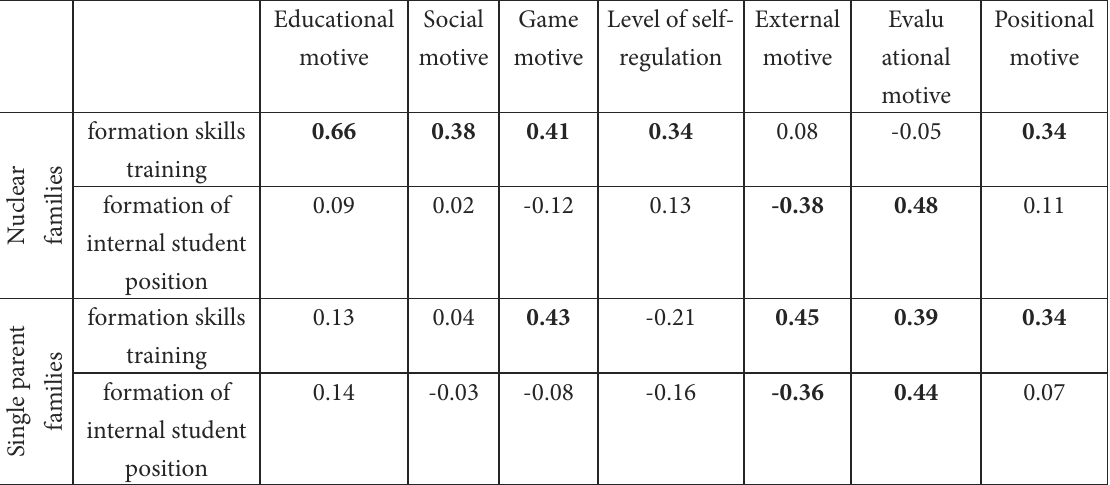
Tab 1. The correlation coef (cid:222) cients for personal indices of children from nuclear and single parent